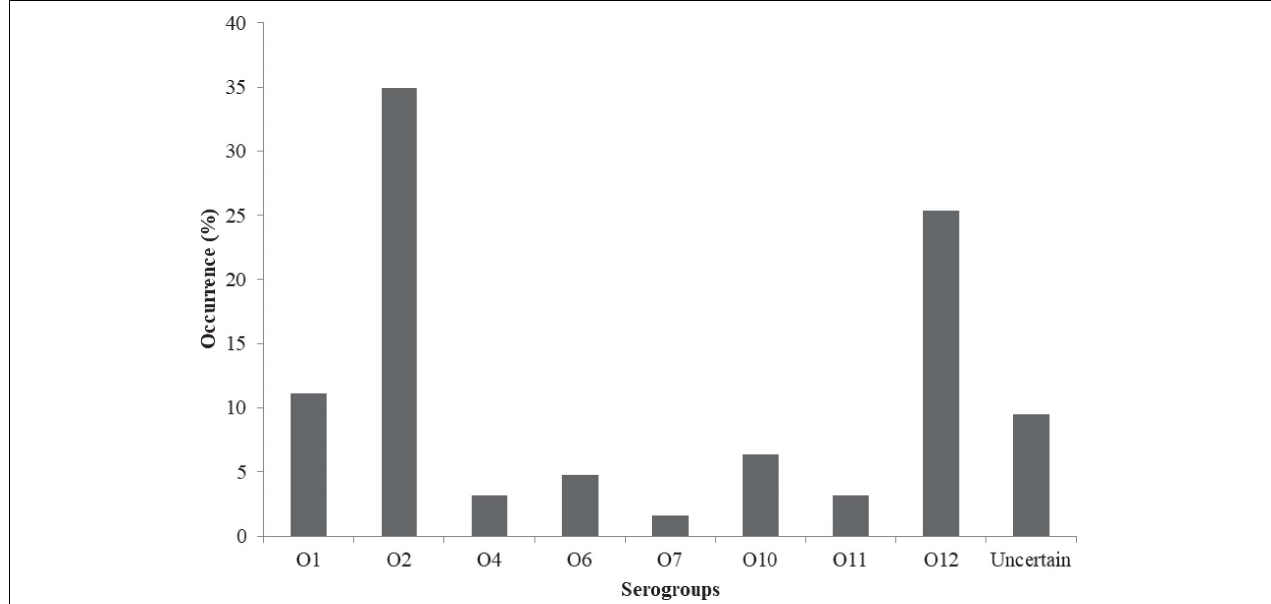
FIGURE 4 | Distribution of serogroups of V. parahaemolyticus from African